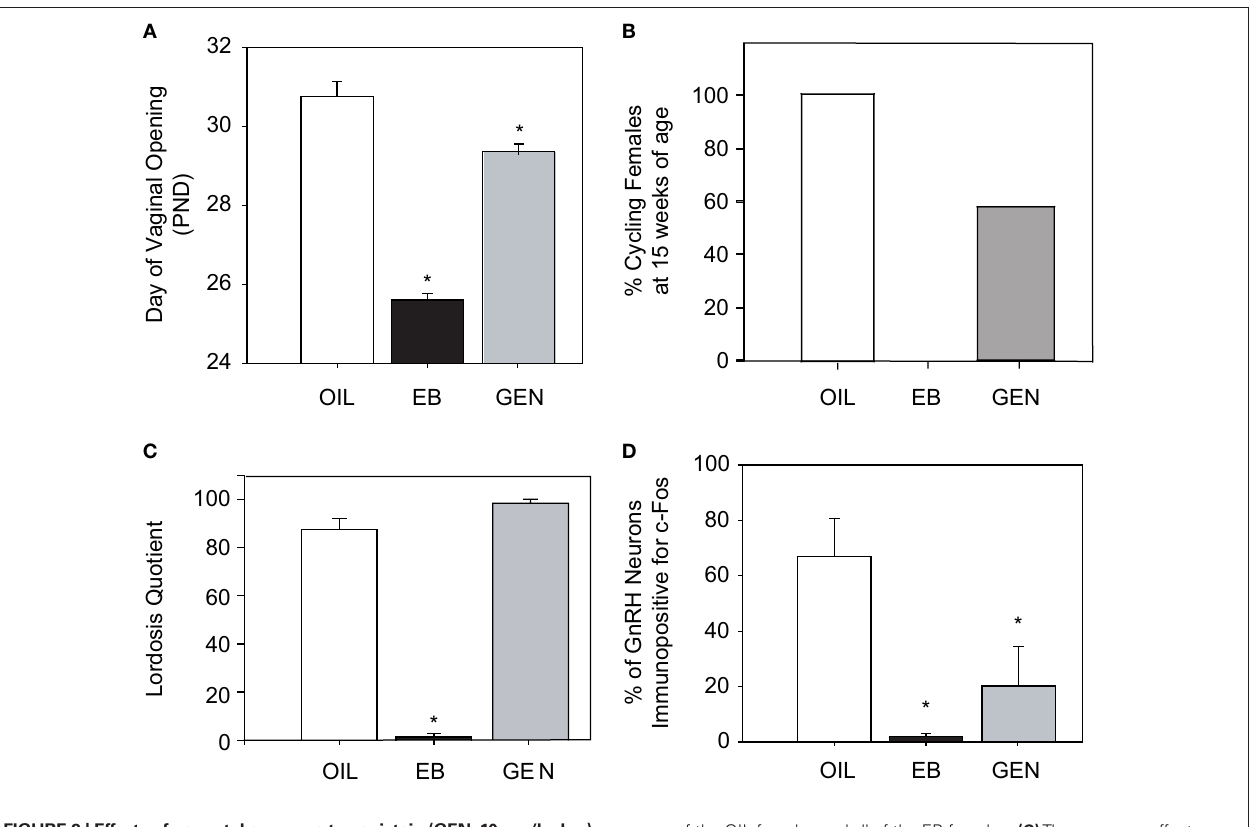
none of the OIL females and all of the EB females. (C) There was no effect of GEN on sexual receptivity (following ovariectomy and hormone priming) however (D) the number of GnRH neurons also immunopositive for Fos was signifi cantly reduced indicating an impaired capacity to display steroid positive feedback. (Panels (A) and (D) adapted from Bateman and Patisaul,